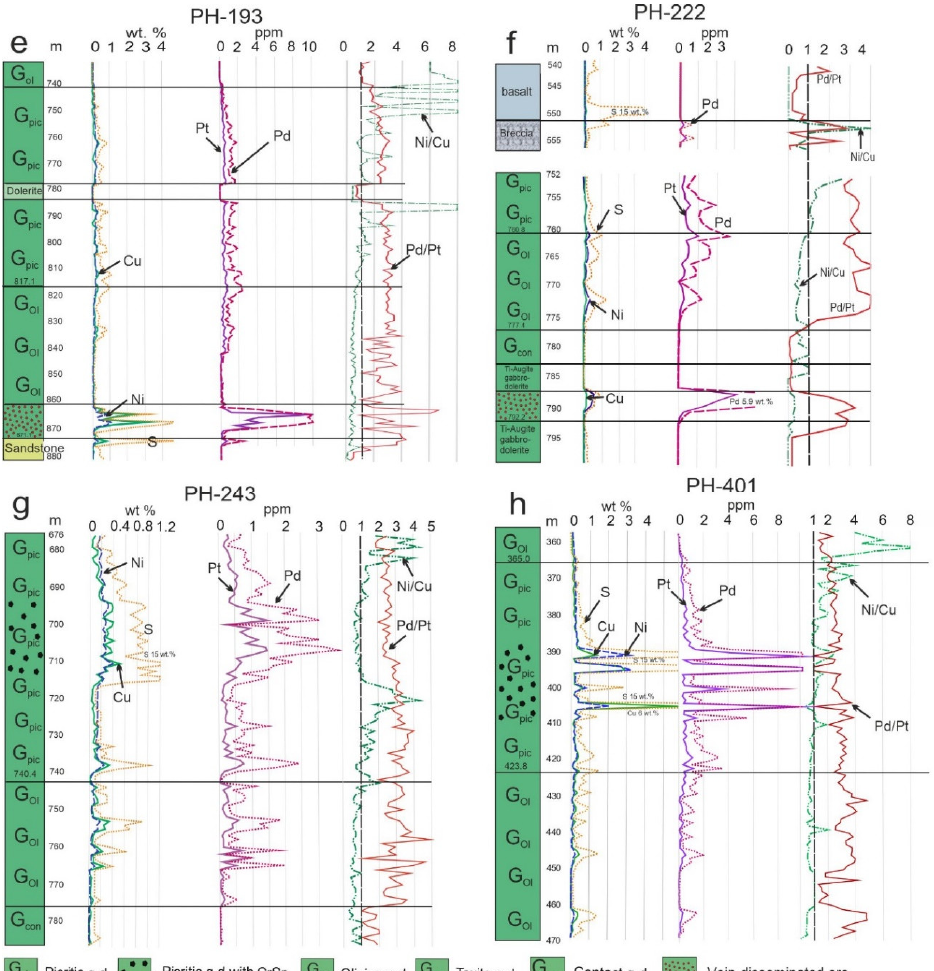
Figure 3. Variations in the contents of ore elements and sulfur in rocks along the cross-section of boreholes; boreholes: ( a ) PH 14, ( b ) PH-72, ( c ) PH-133, ( d ) PH-175, ( e ) PH-193, ( f ) PH-222, ( g ) PH-243, ( h ) PH-401; g–d—gabbro-dolerite, CrSp—chromian spinel. All the names of rocks are given according to the